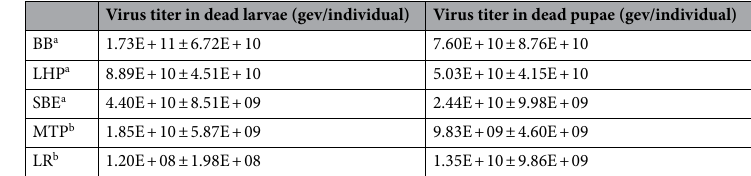
Virus titer in dead larvae (gev/individual) Virus titer in dead pupae